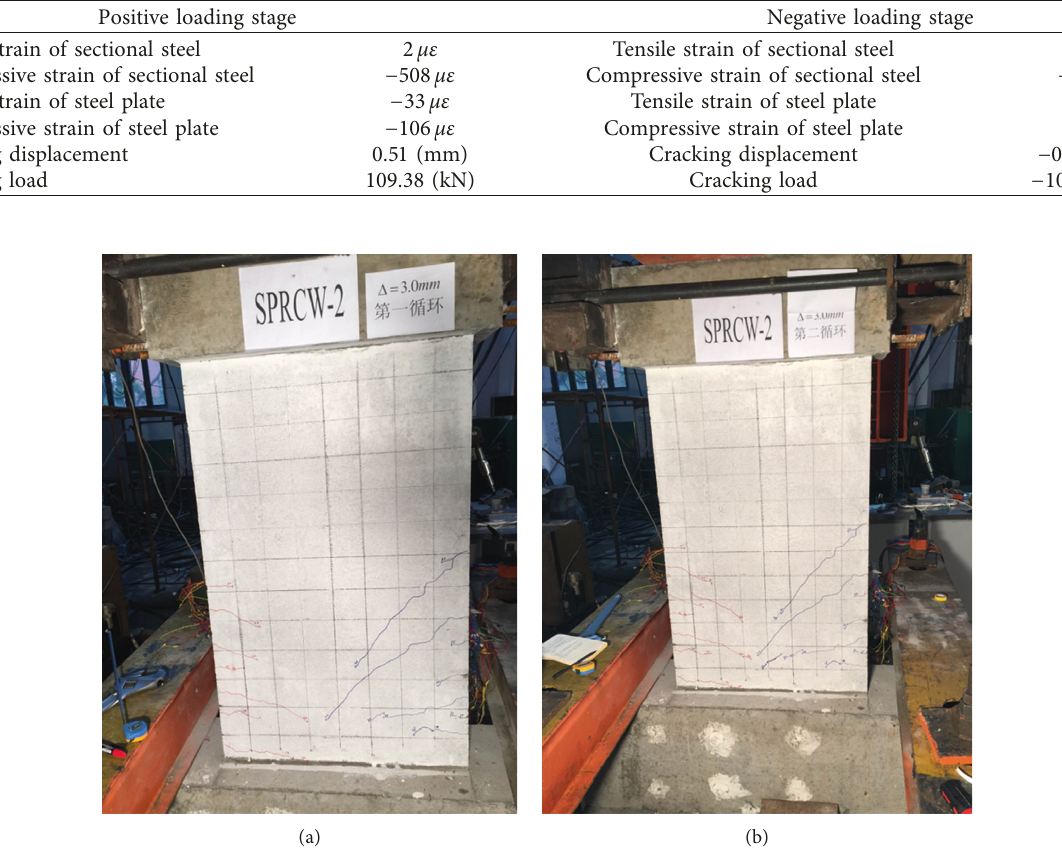
Figure 10: Diagram of cracks in the Δ � 3mm displacement cycle. (a) First cycle. (b) Second